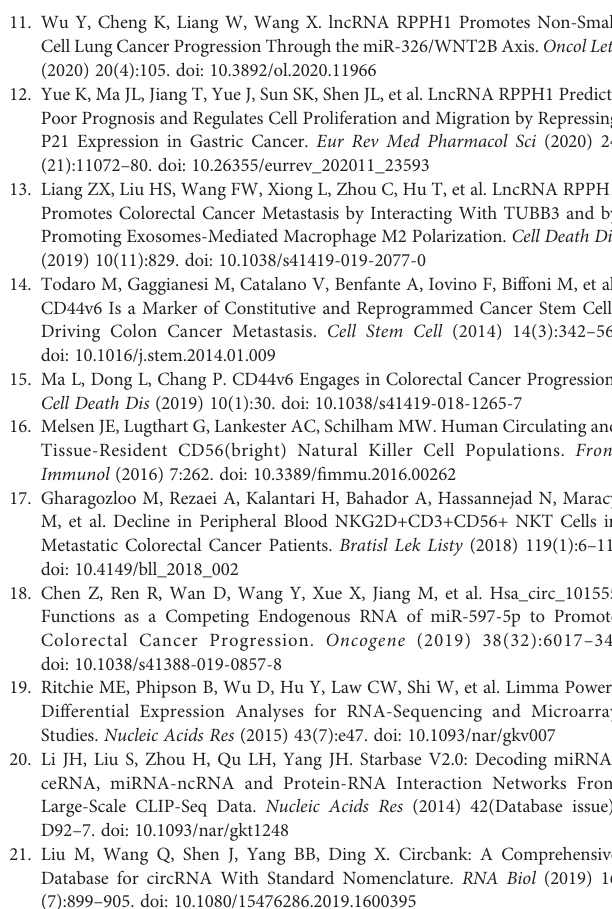
Supplementary Figure S5 | Melting curve of eight circular RNAs (circRNAs) and GAPDH in colorectal cancer (CRC). (A) for hsa_circ_0000511, (B) for hsa_circ_0000512, (C) for hsa_circ_0000514, (D) for hsa_circ_0000515, (E) for hsa_circ_0000517, (F) for hsa_circ_0000518, (G) for hsa_circ_0000519, (H) for hsa_circ_0000520, and (I) for GAPDH. Supplementary Figure S6 | Relative miRNAs and mRNA expression in colorectal cancer (CRC) cells and NCM-460 normal cell. (A) for miRNA-296-5p, (B) for miRNA-1976, (C) for miRNA-1306-5p, (D) for miRNA-326, (E) for miRNA-1296- 5p, (F) for NCAM1, (G) for CD44, (H) for SYP, (I) for NCAPG, (J) for WNT5A, and (K) for POLA1. Supplementary Table S1 | Primers for miRNAs and mRNAs ampli fi cation in the competing endogenous RNA (ceRNA) network. Supplementary Table S2 | The protein binding with eight circular RNAs (circRNAs) from the RBPmap tool. Supplementary Table S3 | Expression levels of eight circular RNAs (circRNAs) in colorectal cancer (CRC) cells as detected by qRT-PCR